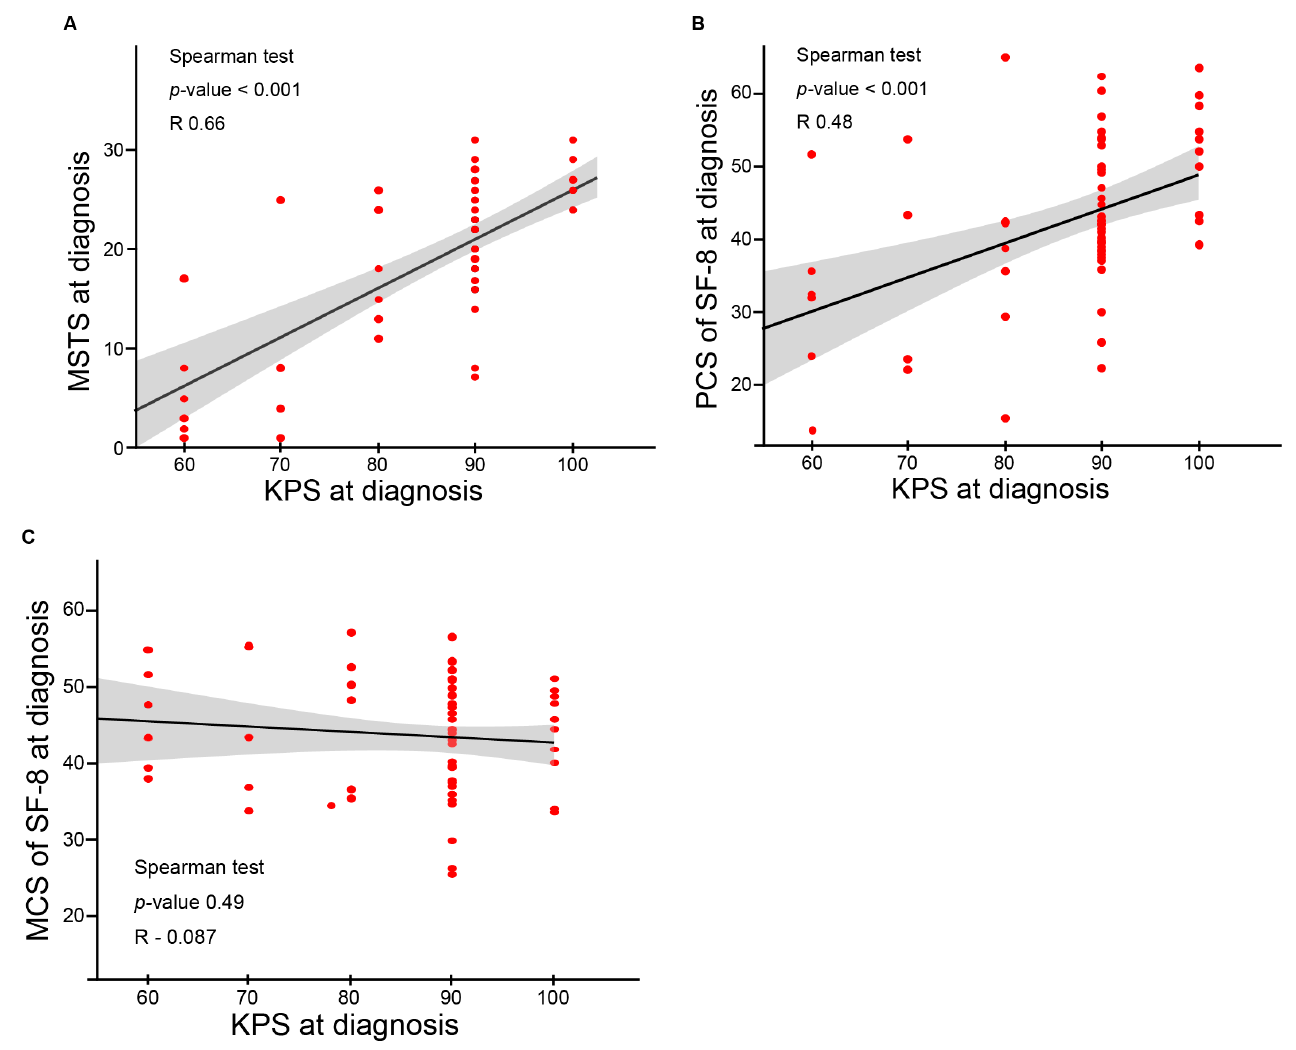
Figure 4. Scatter plots between KPS at diagnosis and baseline scores (MSTS scores and PCS and MCS of SF-8) are shown. Correlation estimates were generated, and regression lines were drawn. ( A ) The baseline MSTS scores were positively correlated with KPS at diagnosis. ( B ) The baseline PCS of SF-8 was positively correlated with KPS at diagnosis. ( C ) The baseline MCS of SF8 showed a weak positive correlation with KPS at diagnosis.